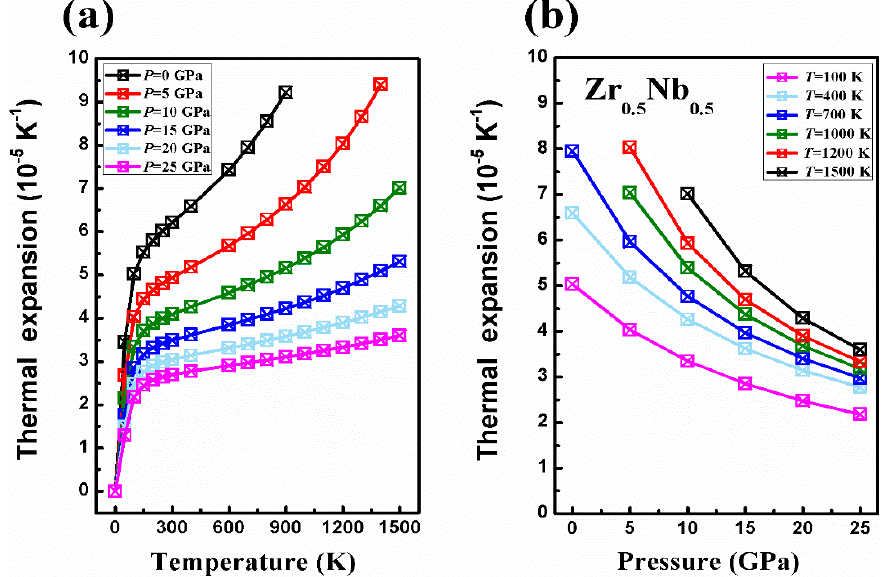
Figure 6. ( a ) Thermal expansion ( α ) as a function of temperature at certain pressures for Zr 0.5 Nb 0.5 ; ( b ) thermal expansion ( α ) versus pressure at certain temperatures for Zr 0.5 Nb 0.5.